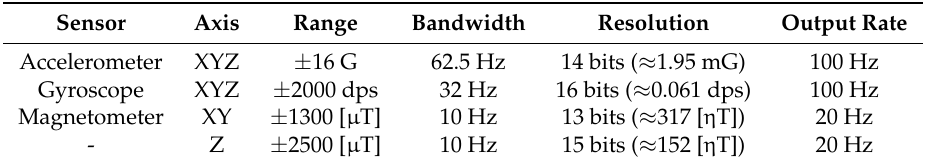
Table 1. Characteristics of the inertial and magnetic sensors of the IMU used.